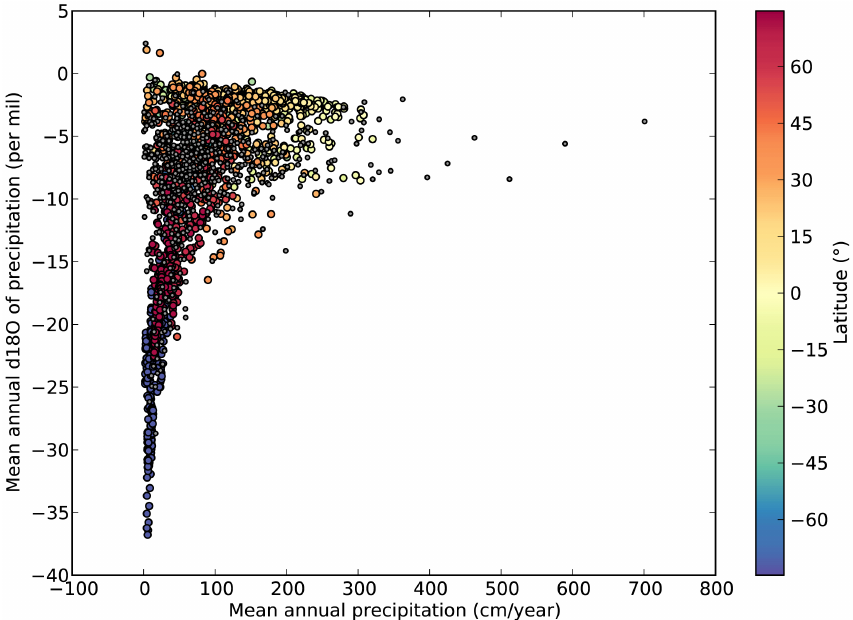
Fig. 4. Annual δ 18 O-precipitation relationship in i LOVECLIM compared to the GNIP database (IAEA, 2006) and Masson-Delmotte et al. (2008) database for Antarctic snow isotopic composition. So-called “precipitation amount” relationship. Coloured circles are from i LOVECLIM: colour indicating their latitude and grey dots are the